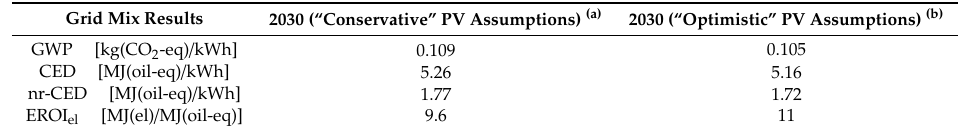
Table 3. Sensitivity Analysis on California domestic grid mix results in 2030, resulting from alternative assumptions on future PV